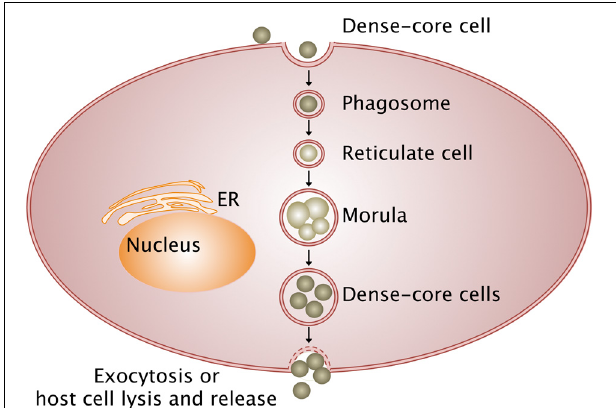
FIGURE 1 | Intracellular life cycle of Anaplasmataceae . The Anaplasmataceae dense-cored cell develops into replicating reticulate cells in the phagosome, which does not fuse with lysosome and forms morulae (vegetative form). Then, reticulate cells mature into dense-cored cells that are liberated by exocytosis or host cell lysis (infectious form). Arrows, transition between stages; ER, endoplasmic reticulum.